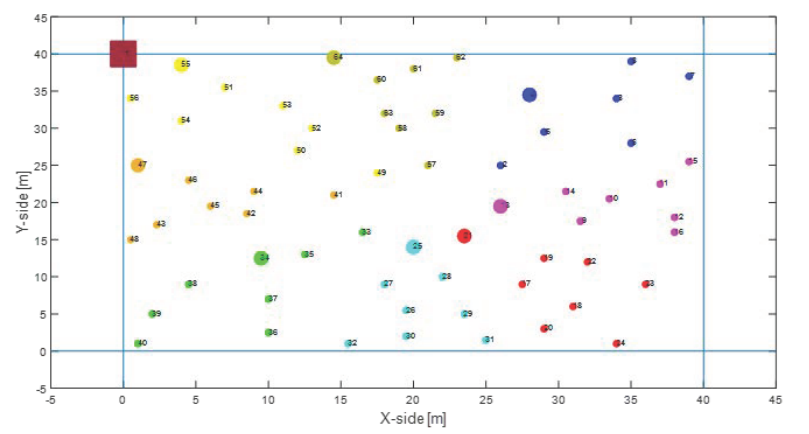
Figure 14. Unbalanced Random Mesh nodes deployment, where clusters are highlighted in different